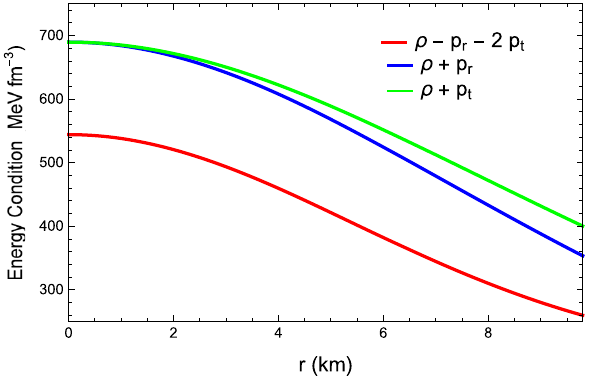
Fig. 6 Different energy conditions plotted against radial coordinate